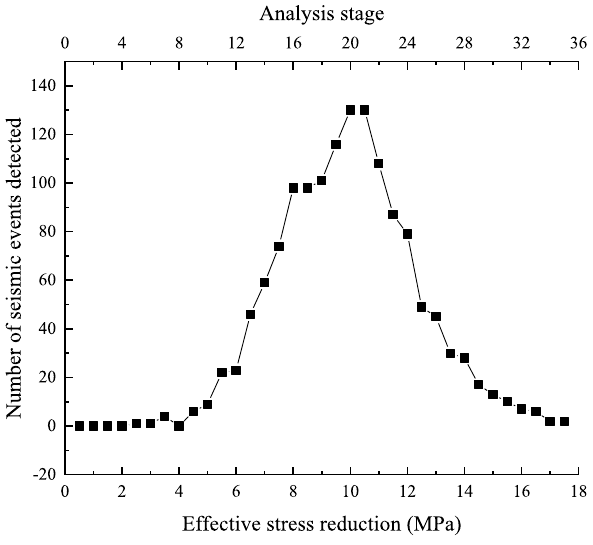
Fig. 10 Number of seismic events detected at each analysis stage while reducing the effective normal stress on the fault core